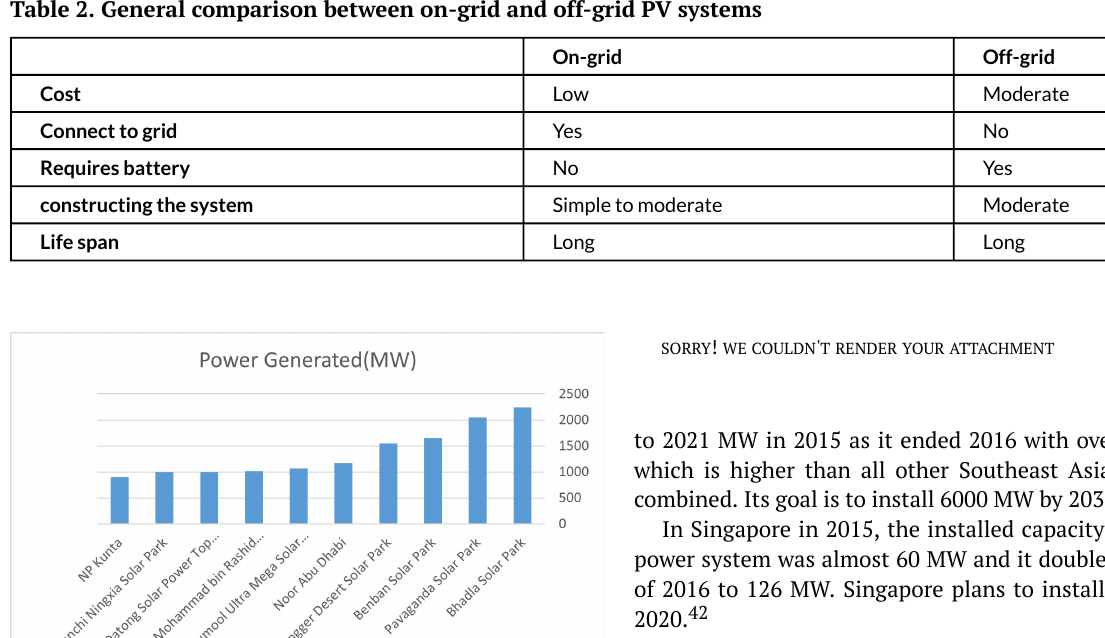
Table 2. General comparison between on-grid and off-grid PV systems